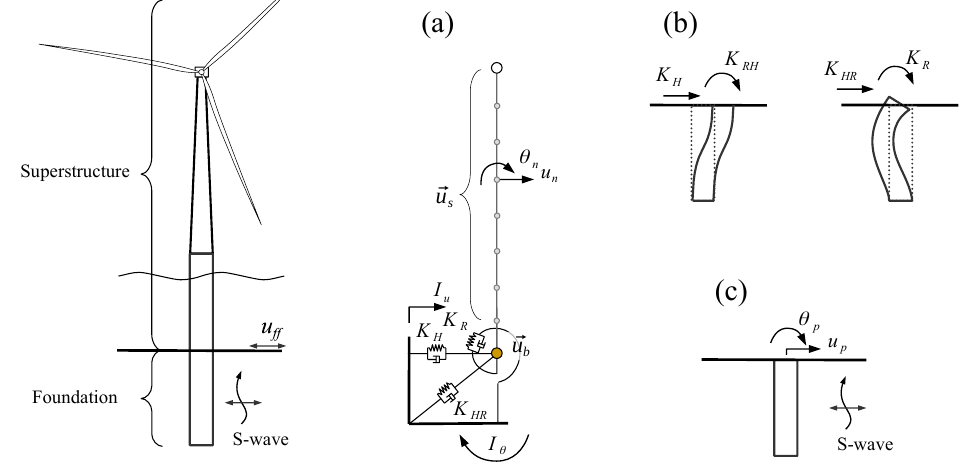
Figure 1. Models used in this work. ( a ) Substructuring model for computing the superstructure response. ( b ) Foundation impedance problem definition. ( c ) Foundation kinematic interaction problem